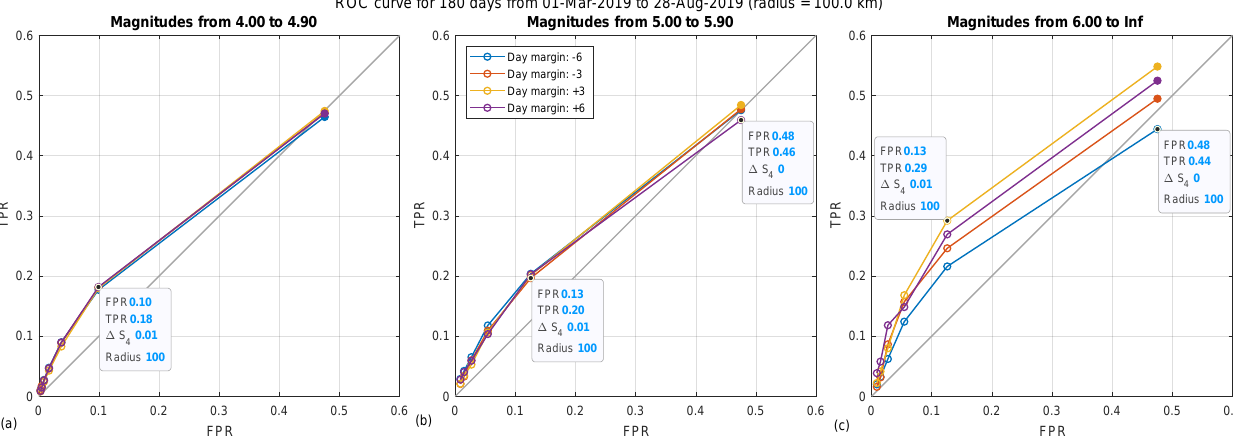
Figure 15. ROC curves for three magnitude intervals using radius = 100